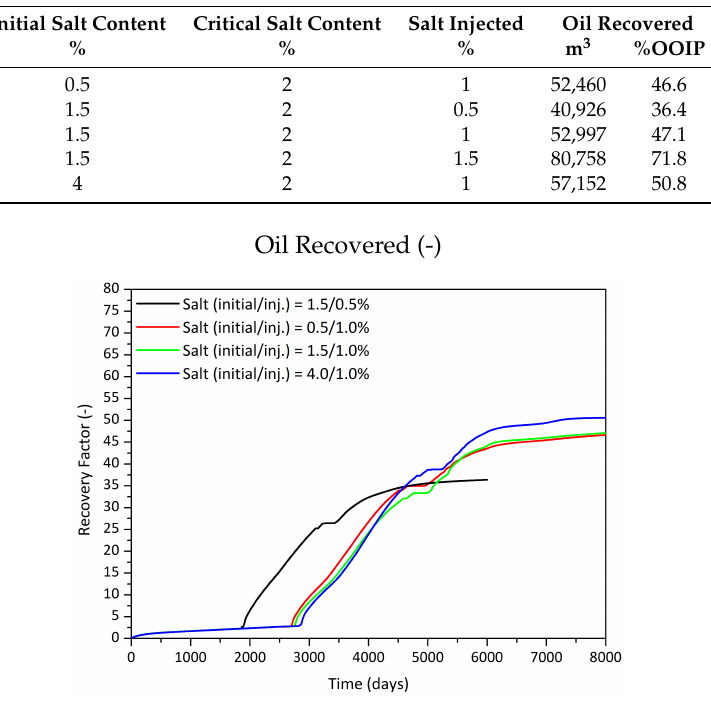
Figure 20. Oil recovered as a function of time for different sets of initial and injected salt concentrations in the